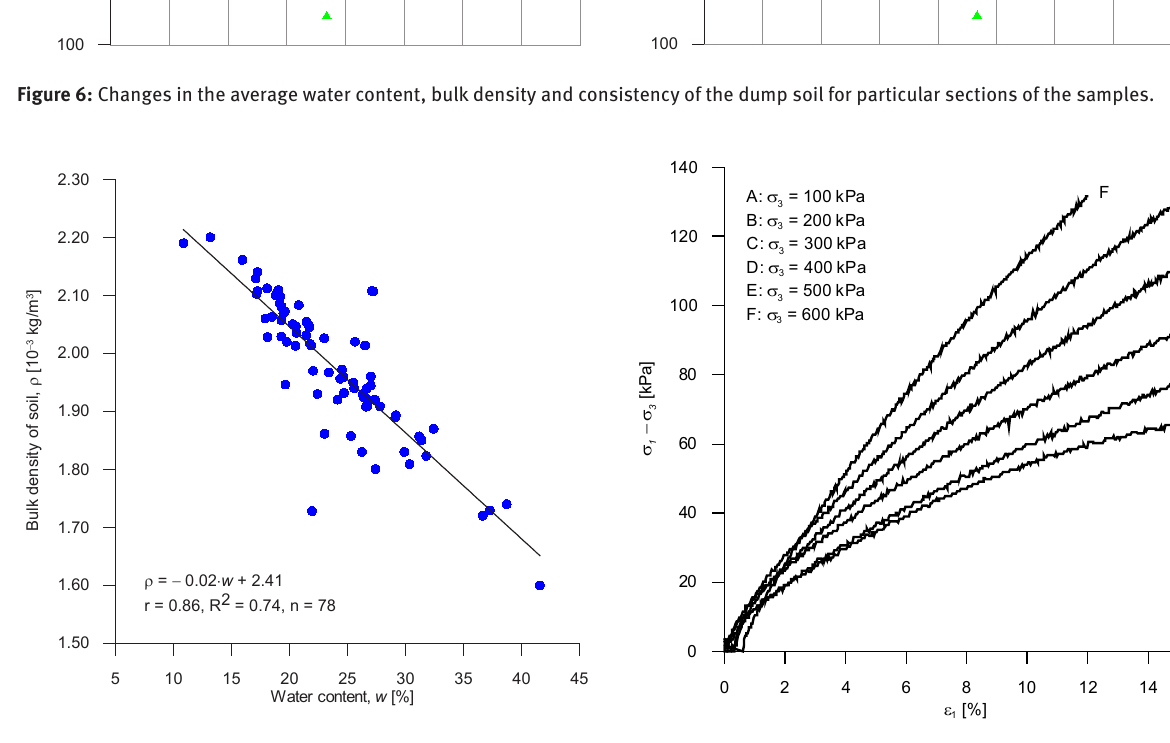
Figure 7: Correlation between bulk density and water content of dump soils.